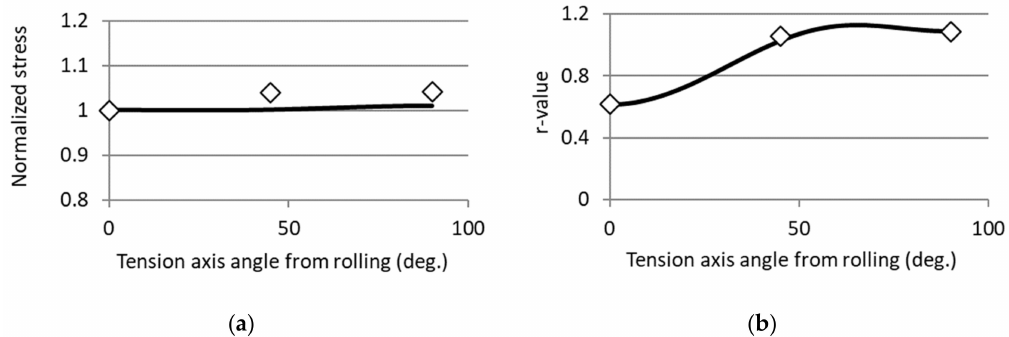
Figure 10. Anisotropic behaviour of the material in where: ( a ) normalized yield stresses using the Hill48 yielding function and ( b ) r -values. The markers show the experimental values, and the continuous line shows the model